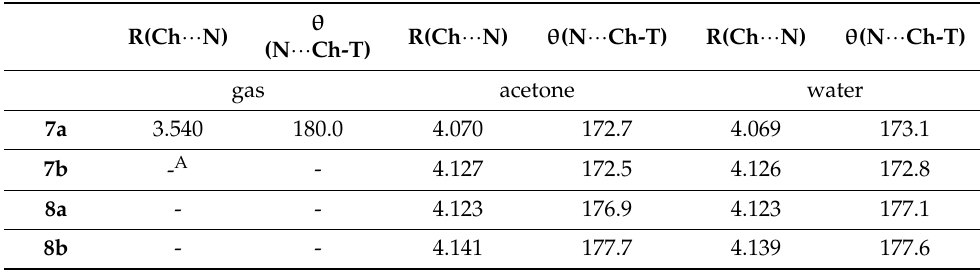
Table 7. Geometrical parameters (distances in Å, angles in deg) for complexes calculated at the MP2/aug-cc-pVDZ level of